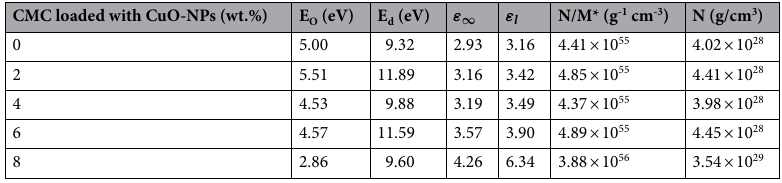
Table 7. Optical dispersion parameters of pristine CMC and CuO-NPs filled CMC films.